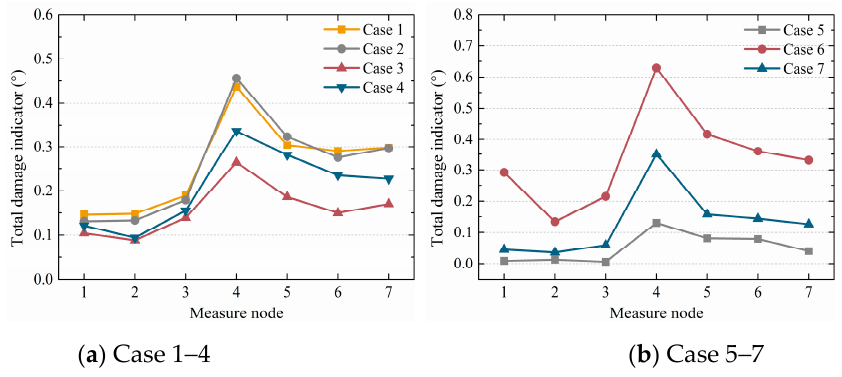
Figure 20. Total damage indicators of cases 1 − 7 as line charts.